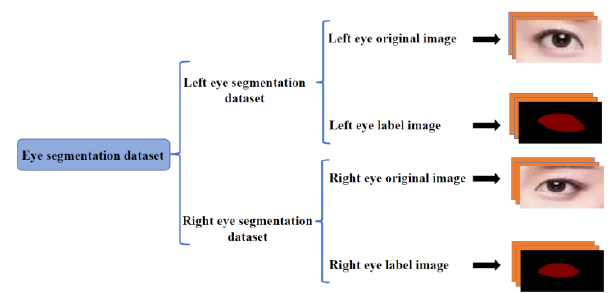
Figure 7. Directory of the eye image segmentation dataset. The images of the left and right eyes cropped from the original eye image are shown in Figure 8 as follows.